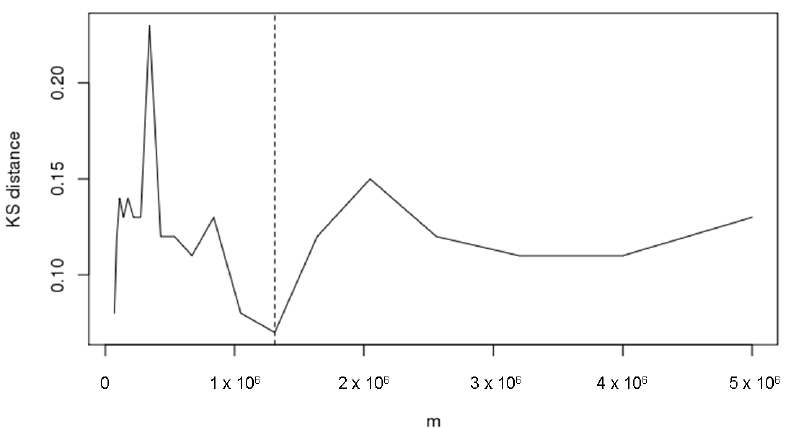
Figure 1. Choice of the optimal m in terms of KS distance from bootstrap distributions ( n = 5,000,000). We get the 99.9% quantile